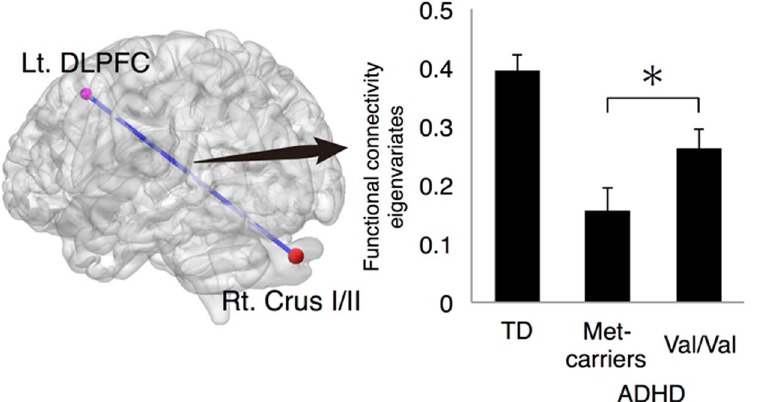
Figure 2. Functional connectivity of the right Crus I/II with the left DLPFC in three groups (TD, ADHD Met-carriers, and ADHD Val-homozygotes). Lt, left; Rt, right; TD, typically developing; DLPFC, dorsolateral prefrontal cortex; * p <